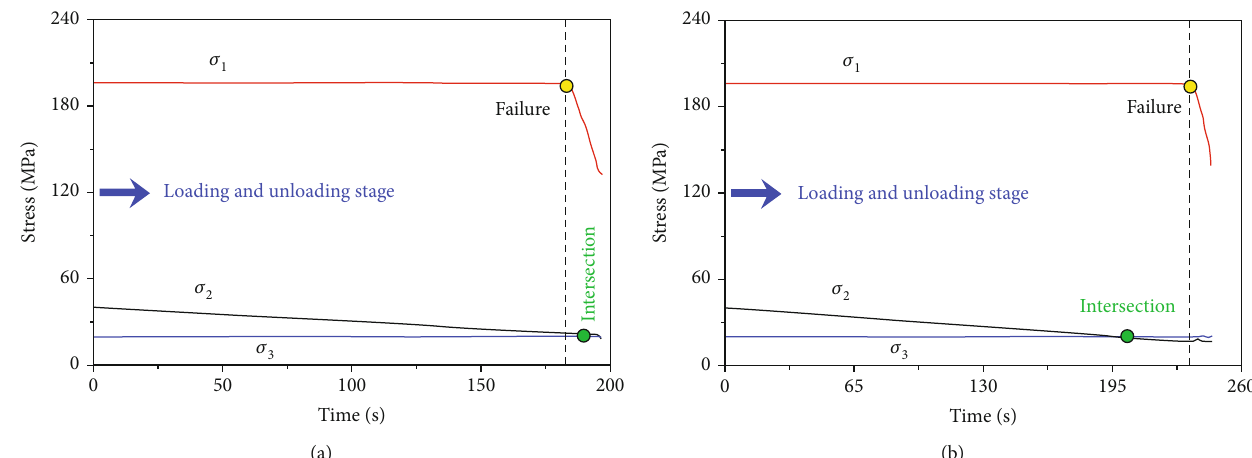
Figure 10: Stress-time curves of two groups of rocks in phase II ( df ) under path II.